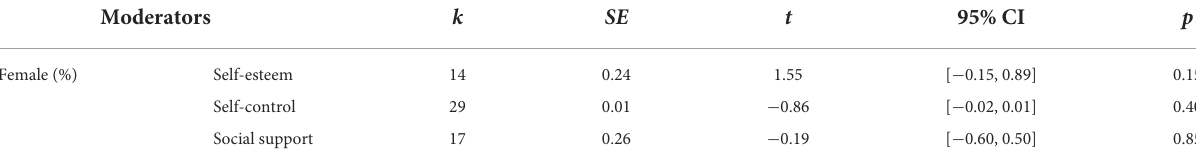
TABLE 4 Univariate regression analysis of continuous variables (random effect